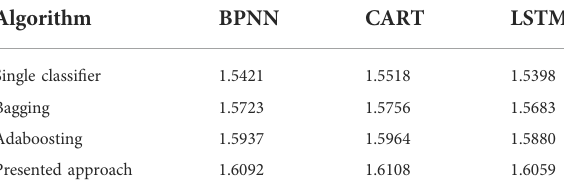
TABLE 6 omparisons of S b of different ensemble learning strategies.